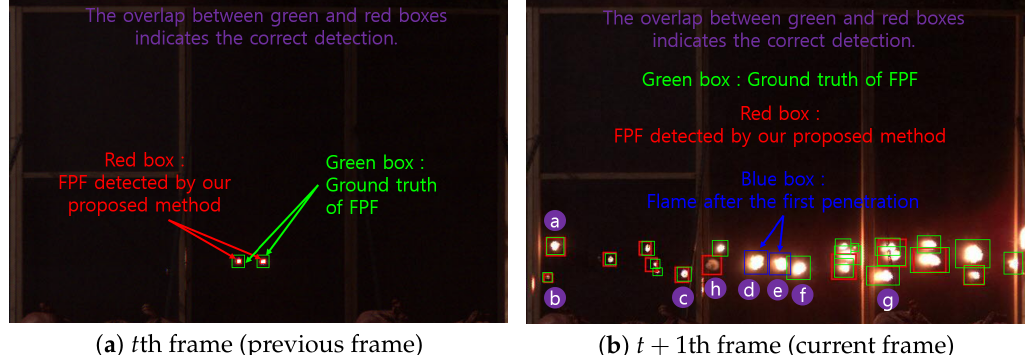
Figure 6. Examples of arena fragmentation test (AFT) images captured with the AFT experiment setup illustrated in Figure 2. Green: First penetrating fragment (Ground Truth). Blue: Flame after the first penetration. Red: First penetrating fragment detected by our proposed method. ( a ) and ( b ) shows FPFs detected by our proposed method and ground truths in t th and t + 1th frames, respectively. In ( b ), the two blue boxes in the middle have similar shapes and appearances with FPFs, but since the corresponding FPFs were detected in the t th frame, they are judged as flames in the t + 1th frame through the proposed algorithm. Note that the green and red bounding boxes can be overlaid. Thus the red box can be occluded by a green box and vice versa.